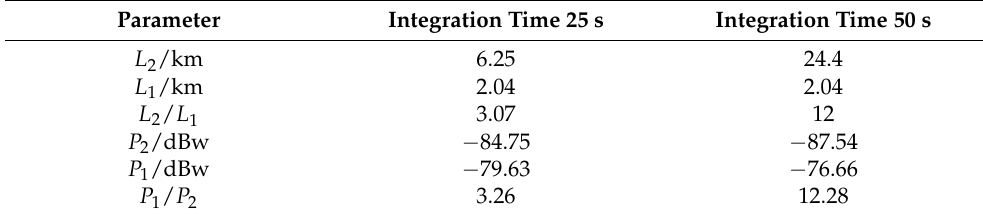
Table 5. Focusing results of LEO-to-GEO RFI scattered by point A.